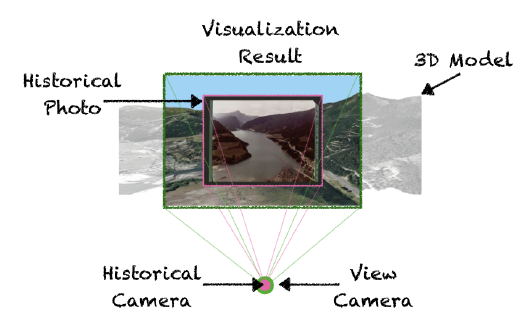
Figure 1. Virtual view of a 3D model from the location of